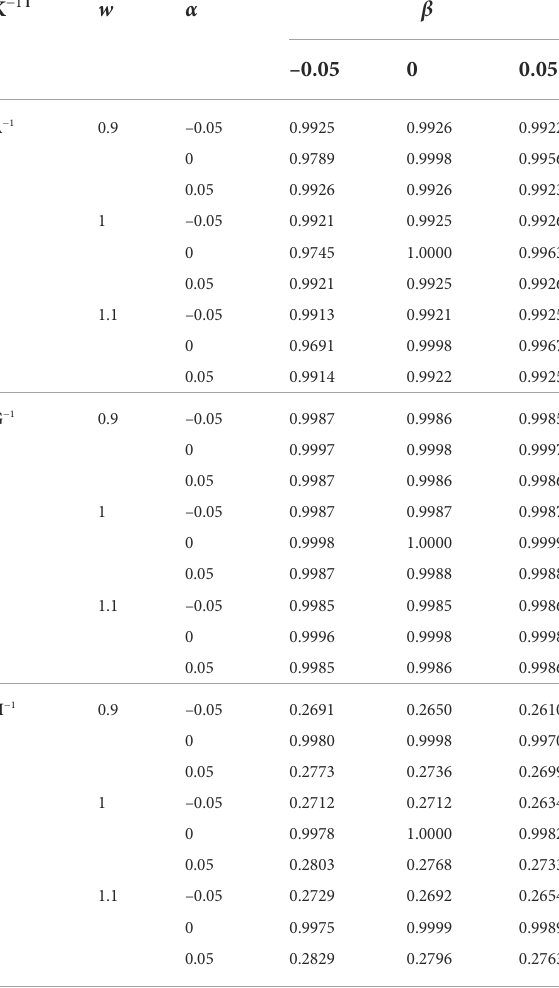
Figure S3. Six rows/columns of H − 1 corresponding to the largest diag( H − 1 ) (ranging from 6.45 to 6.90) were discarded